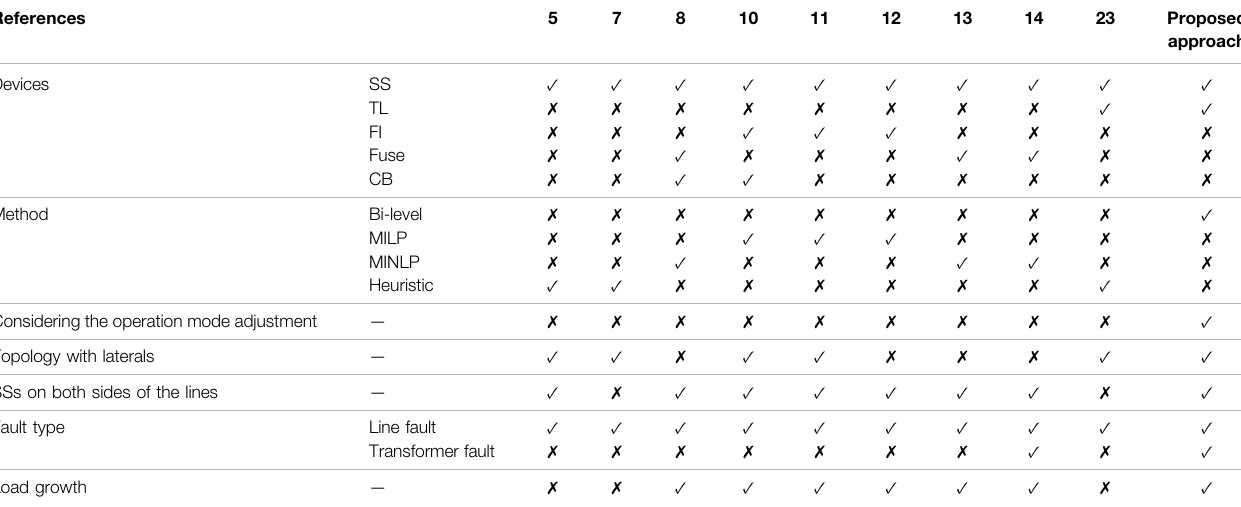
TABLE 1 | Comparison of the proposed approach with other